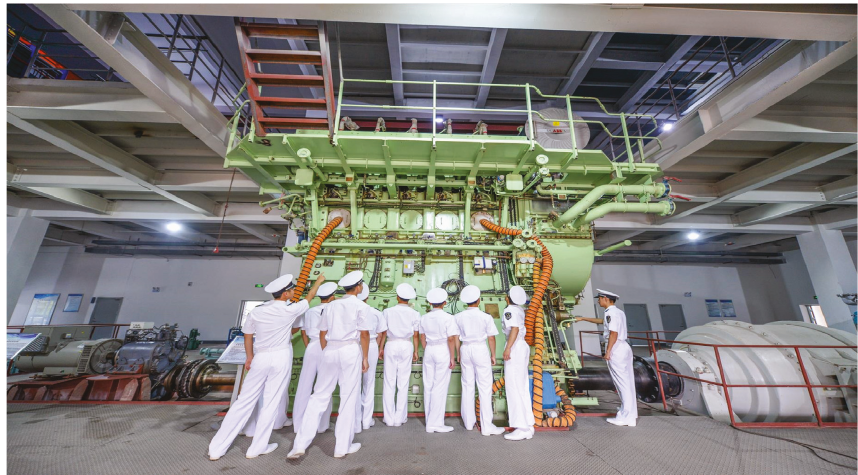
Figure 4: Ashore marine engine room Table 1: The cost elements.